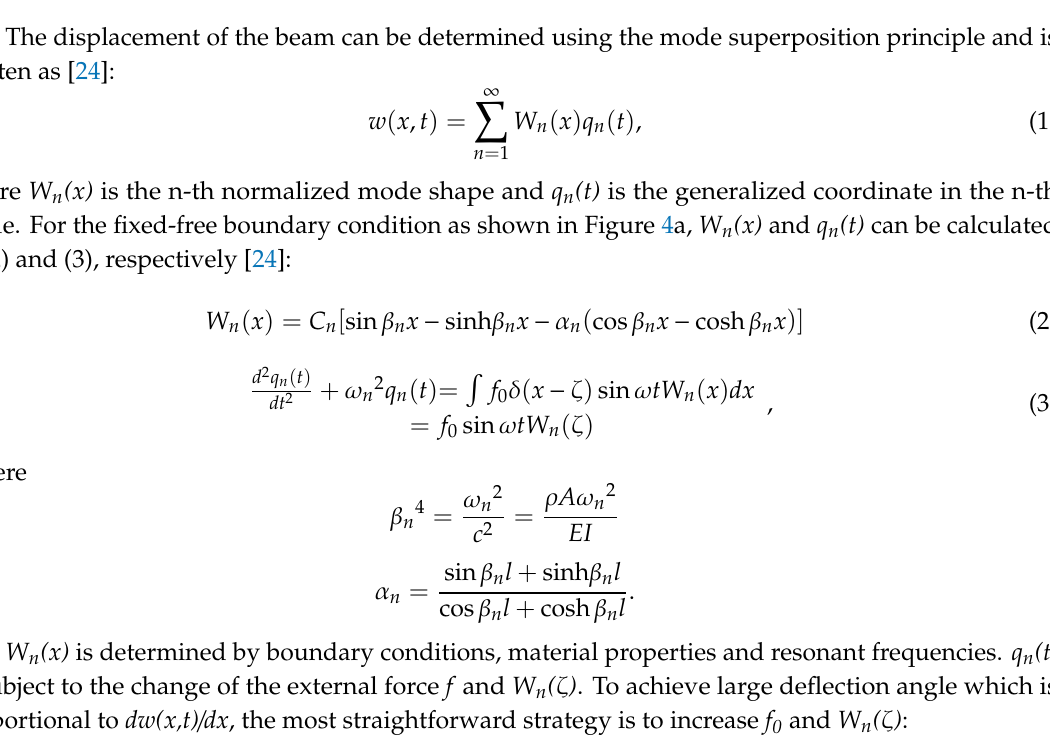
Figure 4. ( a ) A beam is subject to the external force f and ( b ) free ‐ body diagram of an element of a